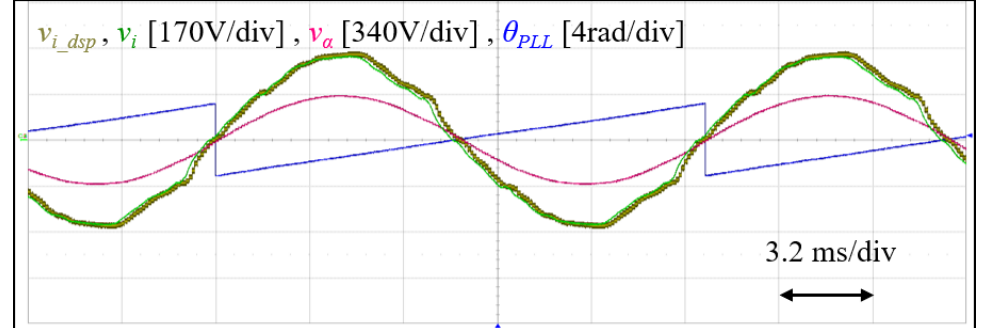
Figure 11. Experimental result showing Grid voltage and phase angle.